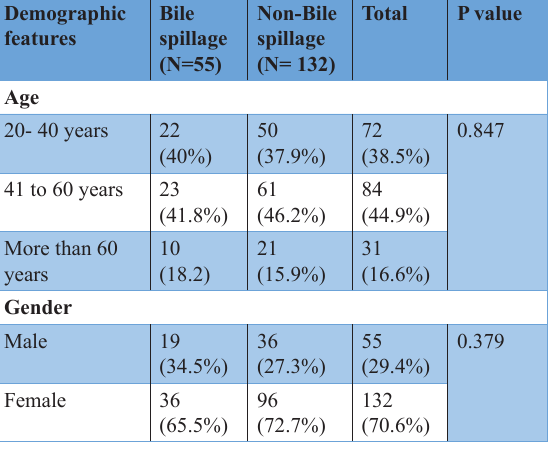
Table 1. Demographic features of patients with bile spillage and non-bile spillage during laparoscopic cholecystectomy.